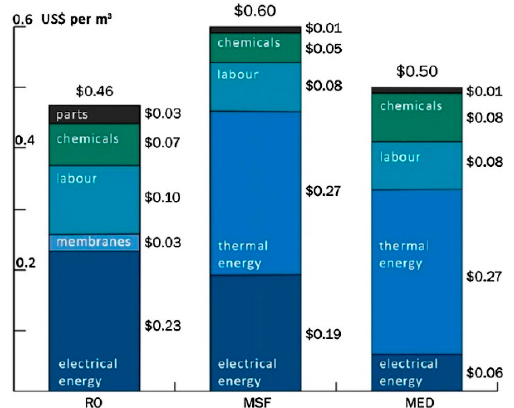
Figure 1. The ultimate water price for each desalination technology [ Error! Reference source not found. ].